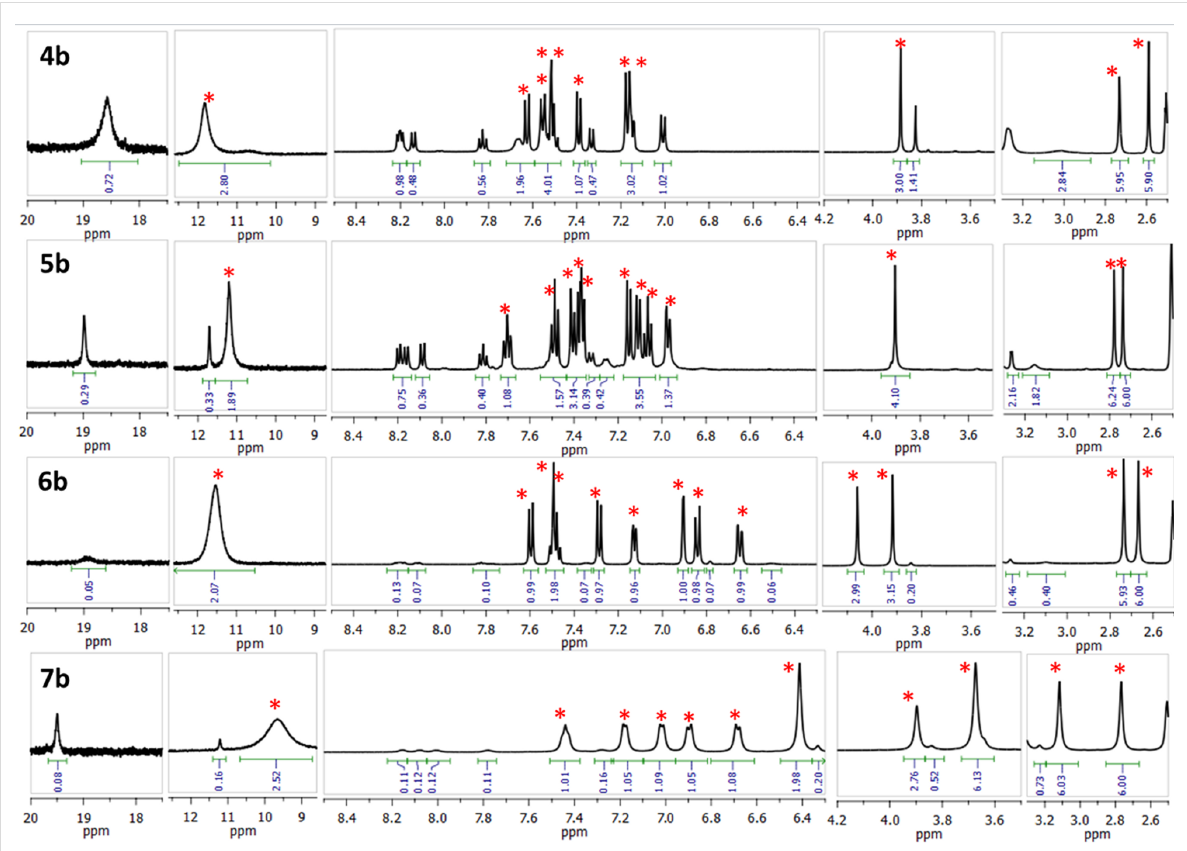
Figure 4: 1 H NMR spectra of imines 4b – 7b ( 4b’ – 7b’ ) in DMSO- d 6 , 25 °C (the signals of the forms protonated at the imino function are marked with an asterisk).